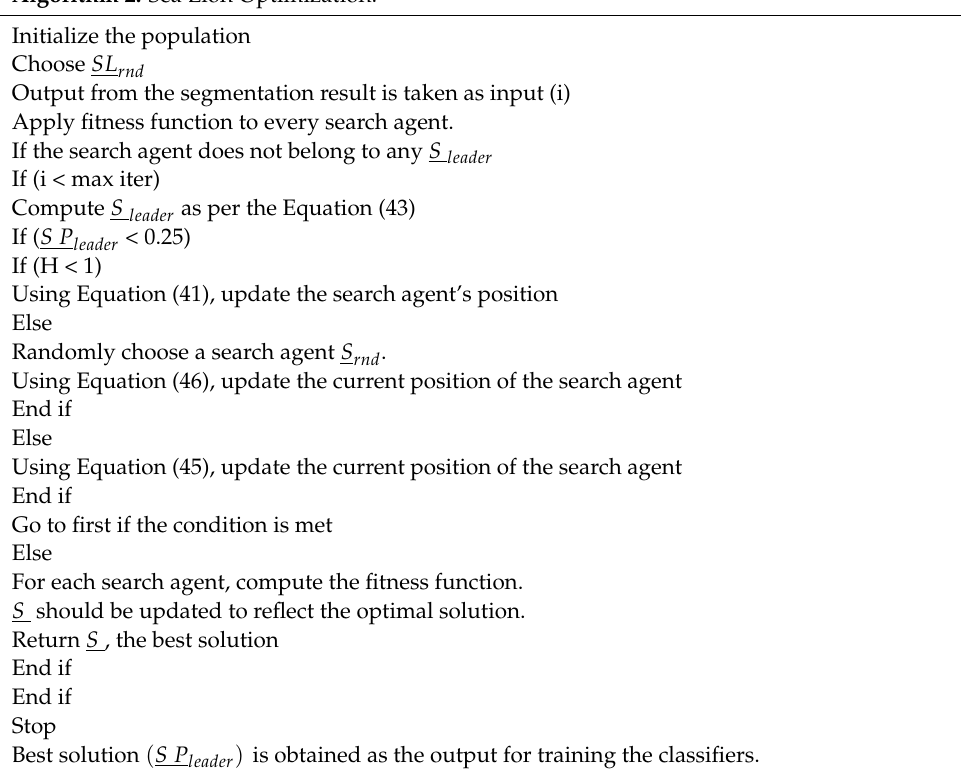
Algorithm 2. Sea Lion Optimization.